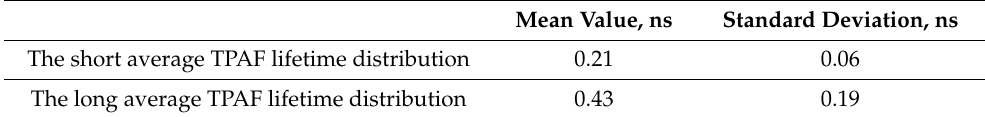
Table 1. Mean and standard deviations for the distributions shown in Figure 8.